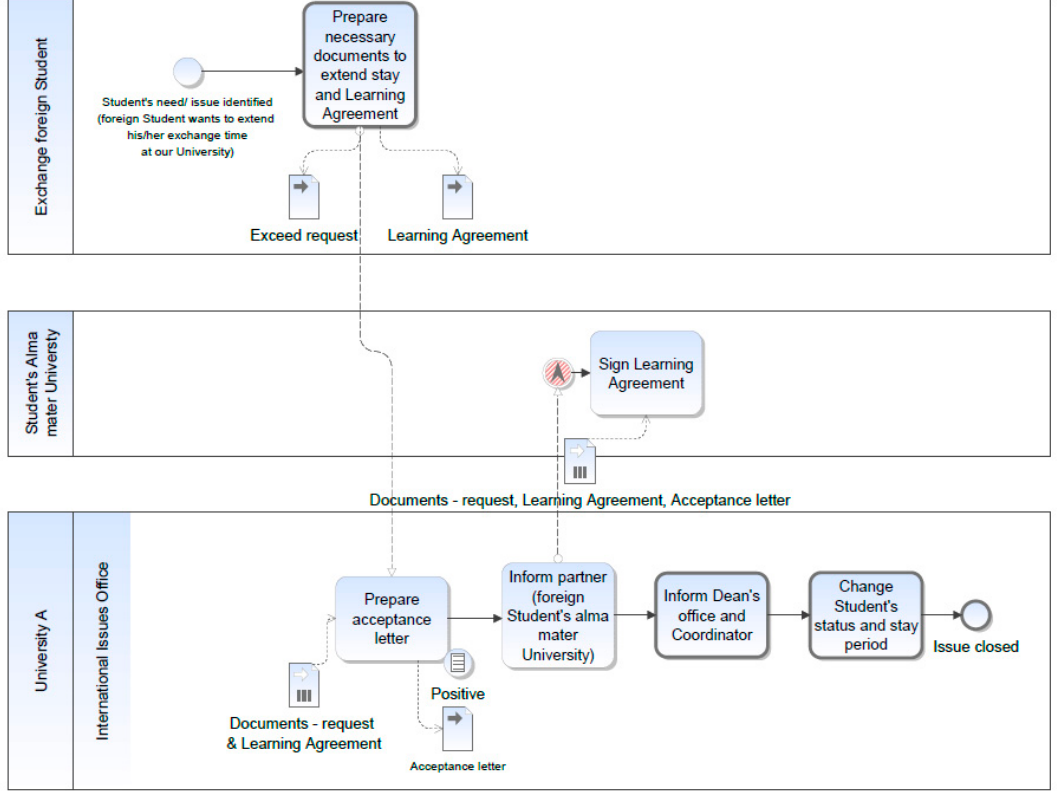
Figure 4. Map of the procedure for extending the stay of a foreign student at a Libyan University.